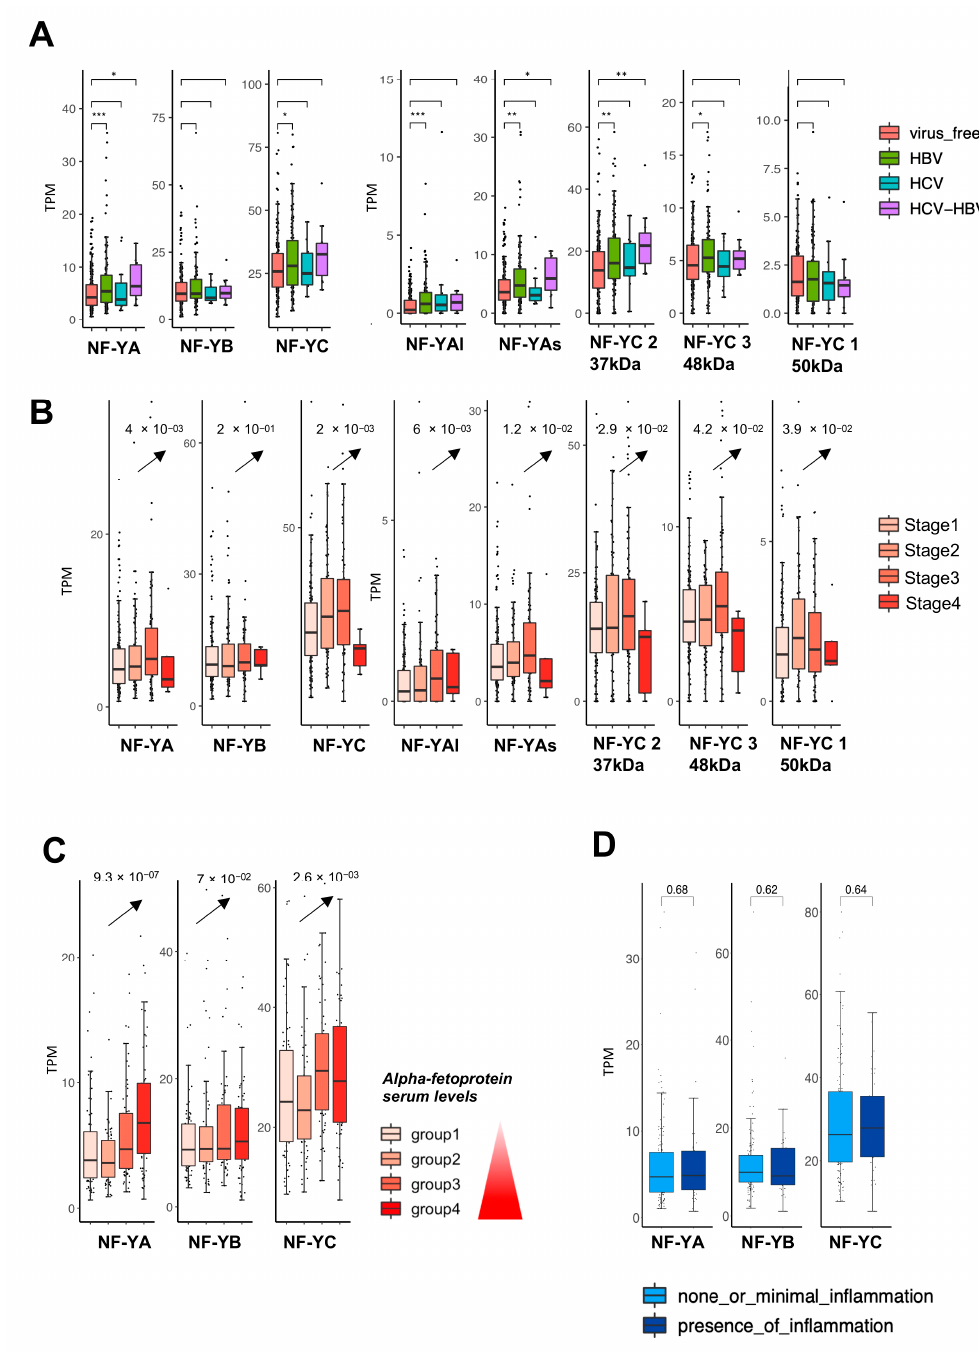
Figure 2. NF-Y expression levels according to viral infection, pathological stage and inflammation status. ( A ) Box plots of expression levels of NF-Y subunits at gene and isoforms levels in virus-positive and virus-free TCGA samples (stars indicate p value significance according to the following criteria: **** < 0.0001; *** < 0.001; ** < 0.01; * < 0.05). ( B ) Box plots of expression levels of the three NF ‐ Y subunits at gene and isoform levels divided according to pathological stage. ( C ) Box plot of NF ‐ Y subunits expression levels after stratification of samples according to alfa ‐ fetoprotein serum levels. ( D ) Box plots of NFY subunits in presence of inflammation compared with low/minimal inflammation.